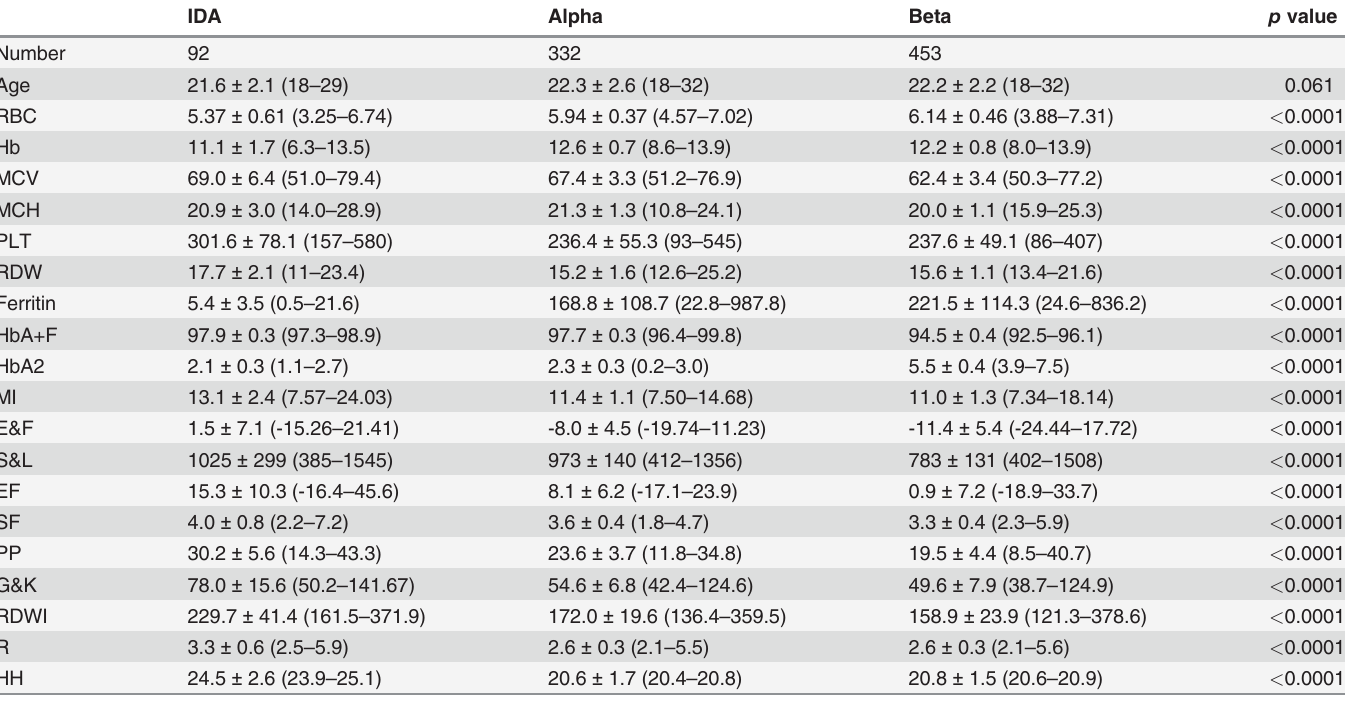
Table 1. Baseline characteristics, hematological parameters and results of different discrimination index among the three study groups. IDA Alpha Beta p